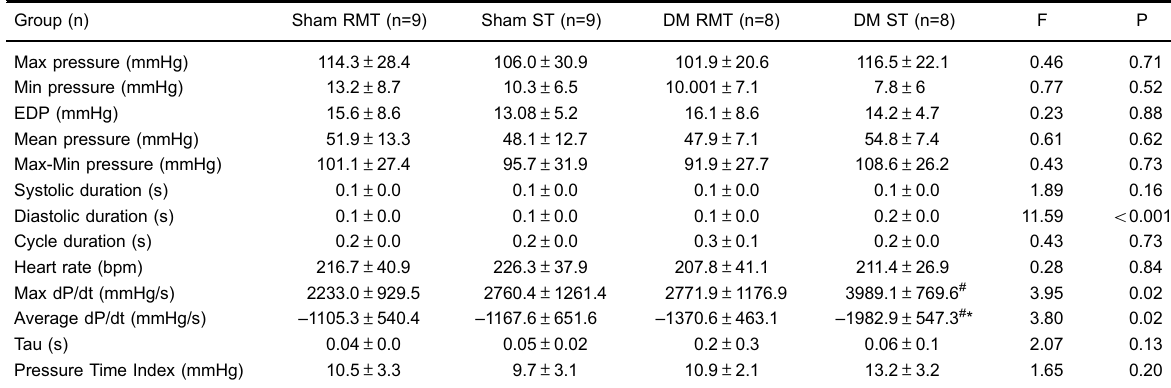
Table 3. Variables of ventricular function and cardiac chamber pressures.